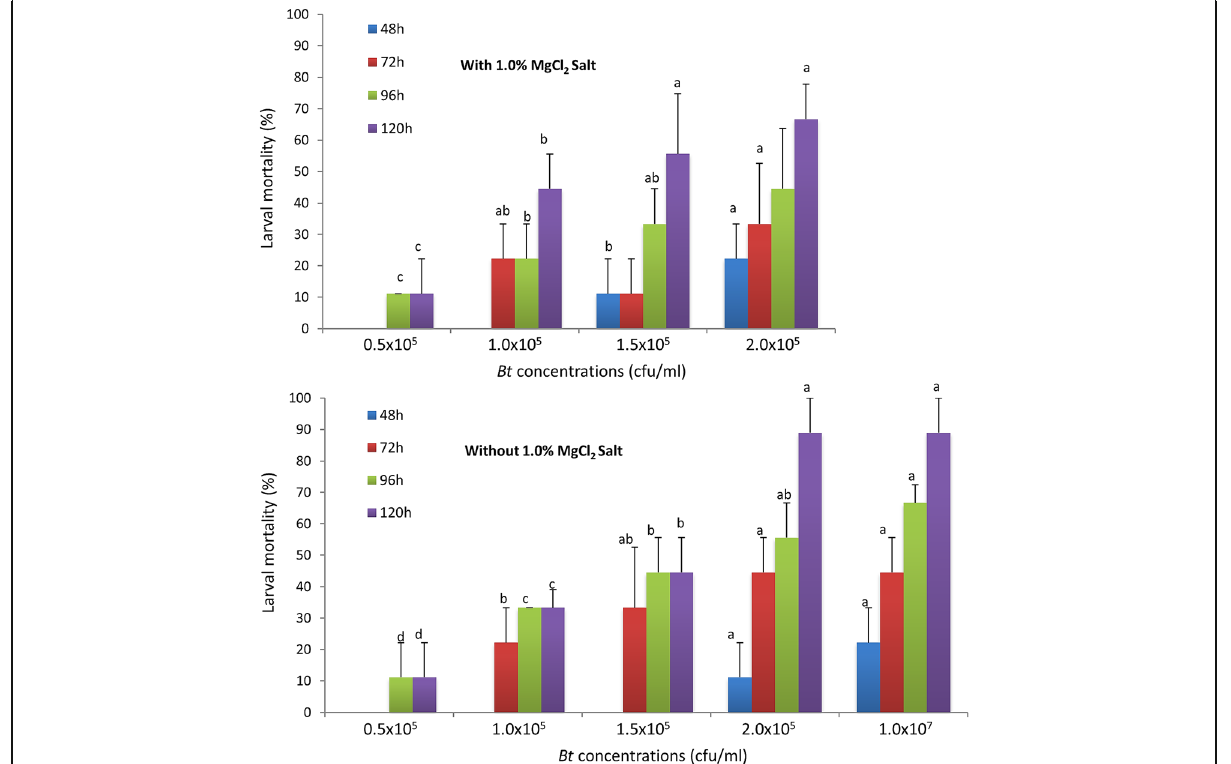
Fig. 1 Mean mortality of the third-instar larvae of Helicoverpa armigera Hübner exposed to different concentrations of Bacillus thuringiensis isolate with or without 1.0% MgCl2 salt. Columns represent mean percent mortality ± standard error ( n = 4). For each time interval, bars with similar alphabetic letters are not significantly different (ANOVA; P ≤